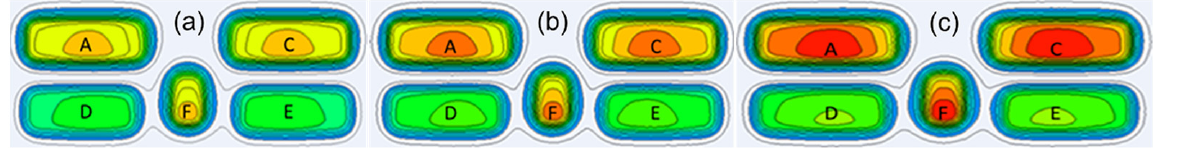
Figure 9. Funnel mold electromagnetic field cloud map. ( a ) 300-200, ( b ) 800-600 and ( c ) 1100-800 A.